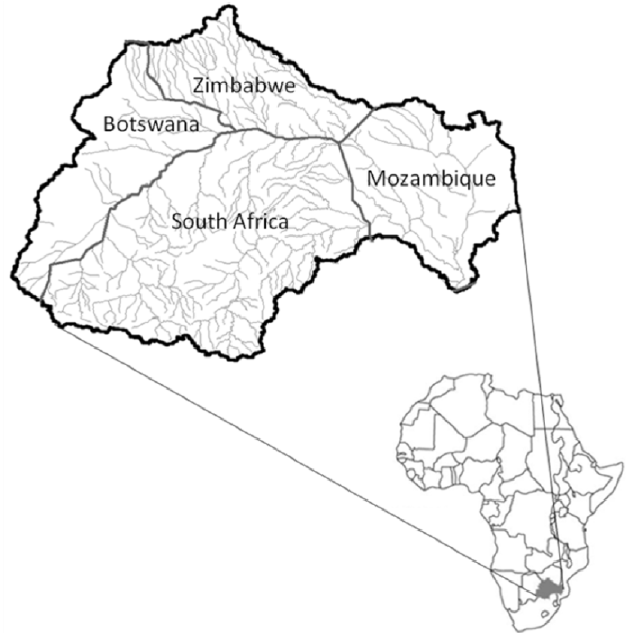
Figure 1. Map of the Limpopo River Basin and boundaries of the four riparian countries. Source: Adapted from IDIS Basin Kit database [11].